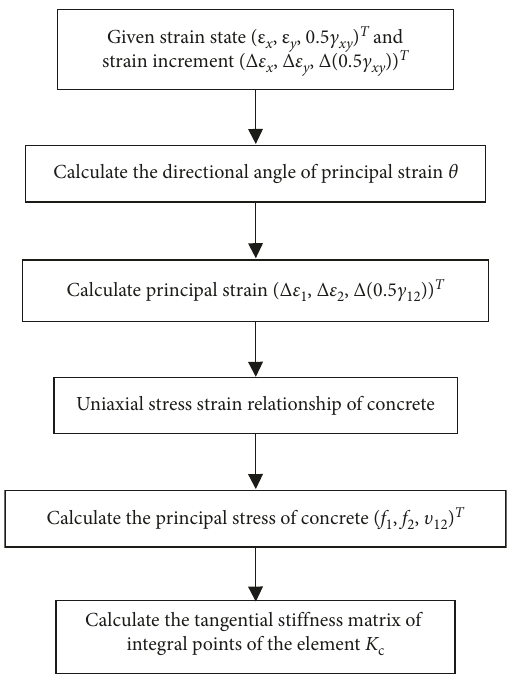
Figure 7: Flowchart of the rotation crack modeling using ABAQUS subroutine.